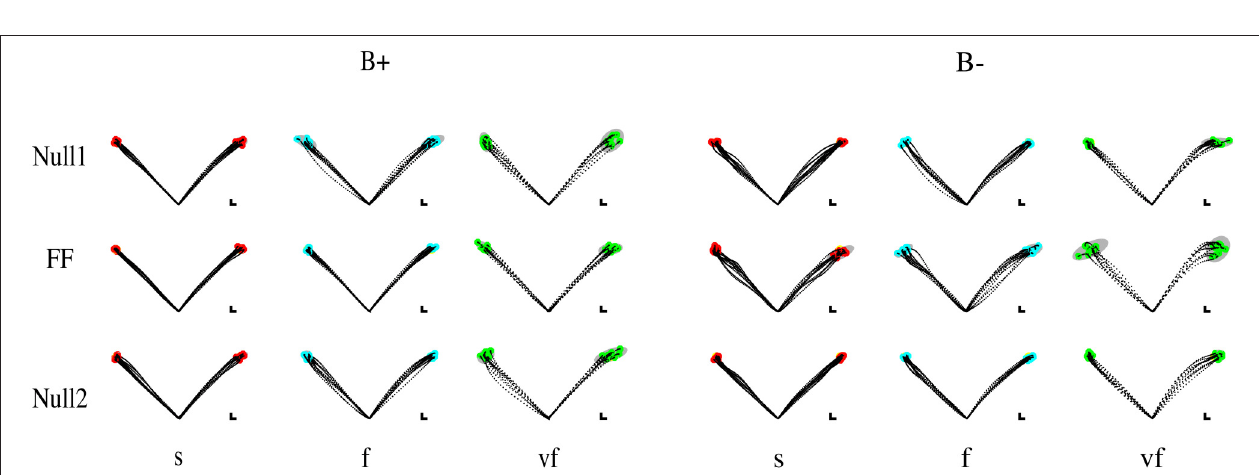
FIGURE 2 | Sample movements for different speeds, phases, and field directions, in two typical subjects in groups K + (left) and K − (right). Rows denote the different phases (from top to bottom, Null1, Field, and Null2). The columns refer to different speeds (from left to right: slow, fast, very fast), with end point displayed in red (slow), cyan (fast), and green (very fast) and with 99 % confidence ellipses of final hand position in gray.